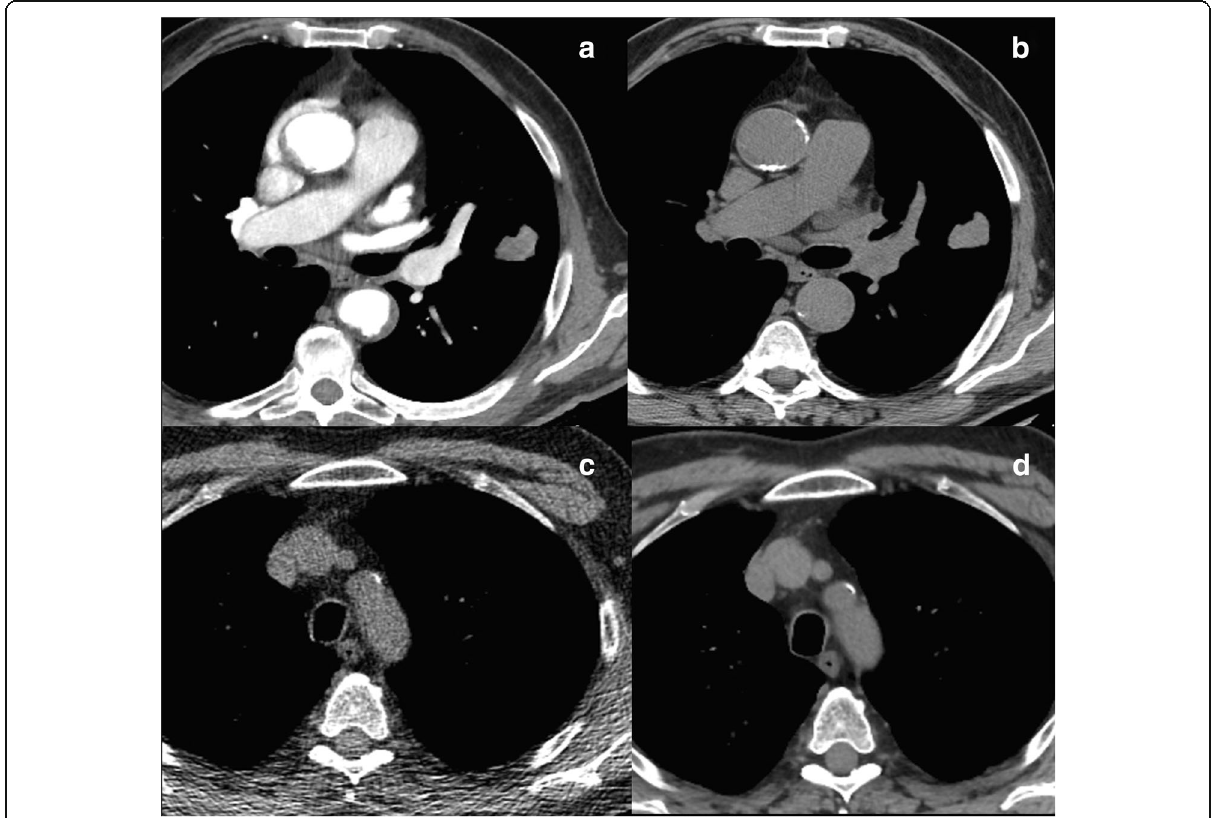
Fig. 2 Axial computed tomography images showing differences in the same acquisition plane between a contrast-enhanced ( a ) and an unenhanced image ( b ), as well as for different radiation doses, lower in ( c ), and higher in ( d